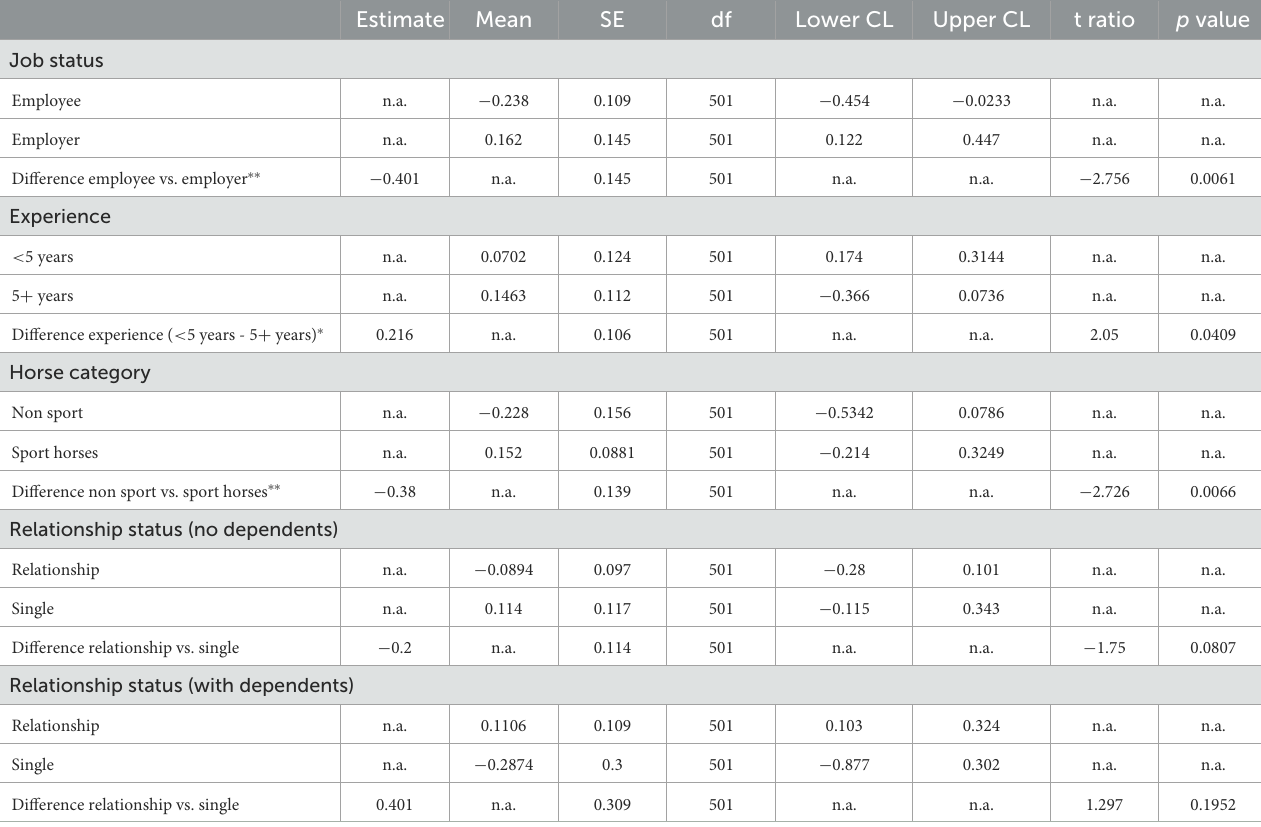
TABLE 5 Effect of factor “team culture and learning possibilities” on overall work satisfaction for job status, experience, horse category and relationship status (with/without